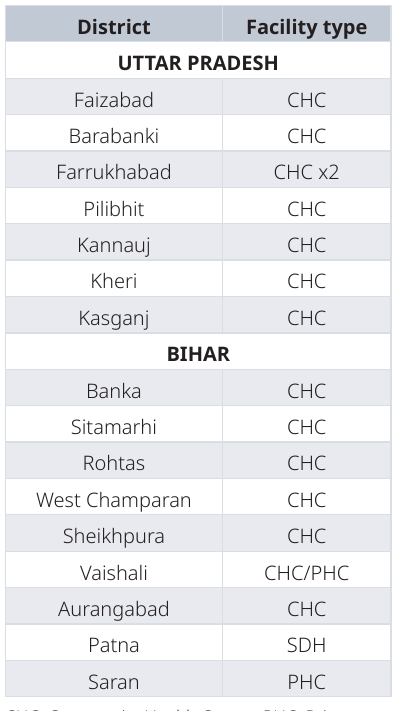
Table 1. Summary of public health facilities visited for data